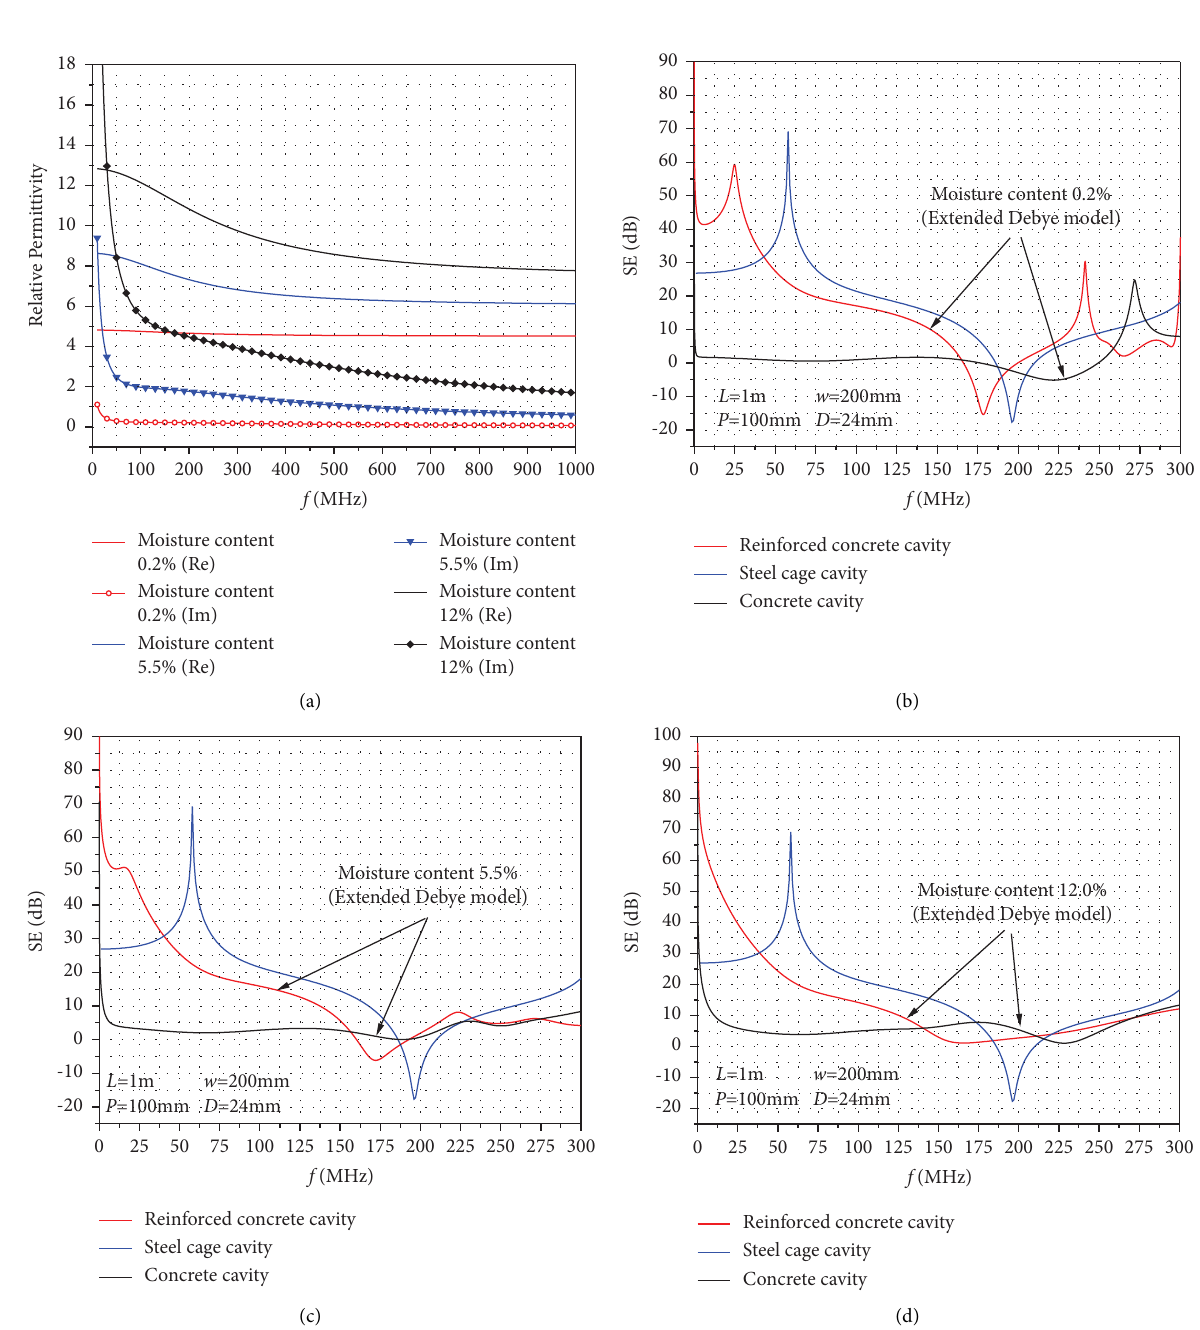
Figure 6: Comparison of the shielding efectiveness of three shielding structures under diferent moisture content: (a) complex permittivity of the concrete with the moisture content, (b) moisture content 0.2%, (c) moisture content 5.5%, and (d) moisture content